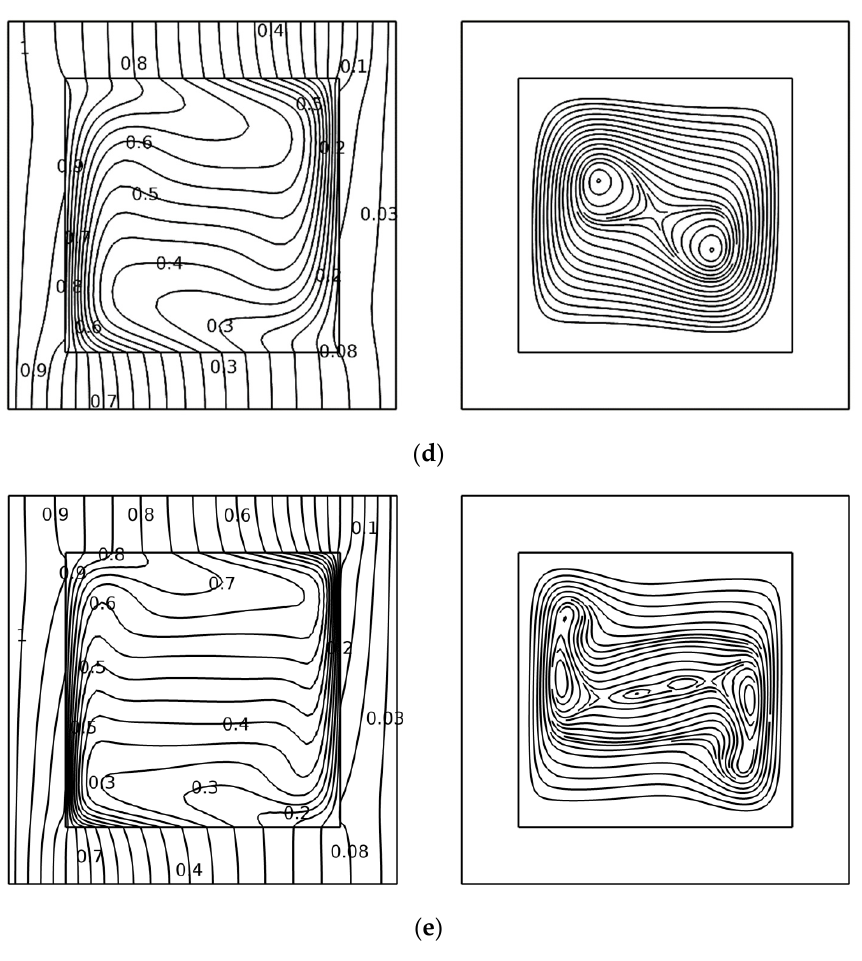
Figure 3. Streamlines and isothermals obtained for ( a ) Ra = 10 2 , W max = 0.5111, ( b ) Ra = 10 3 , W max = 4.804, ( c ) Ra = 10 4 , W max = 24.808, ( d ) Ra = 10 5 , W max = 80.813 and ( e ) Ra = 10 6 , W max = 229.87.